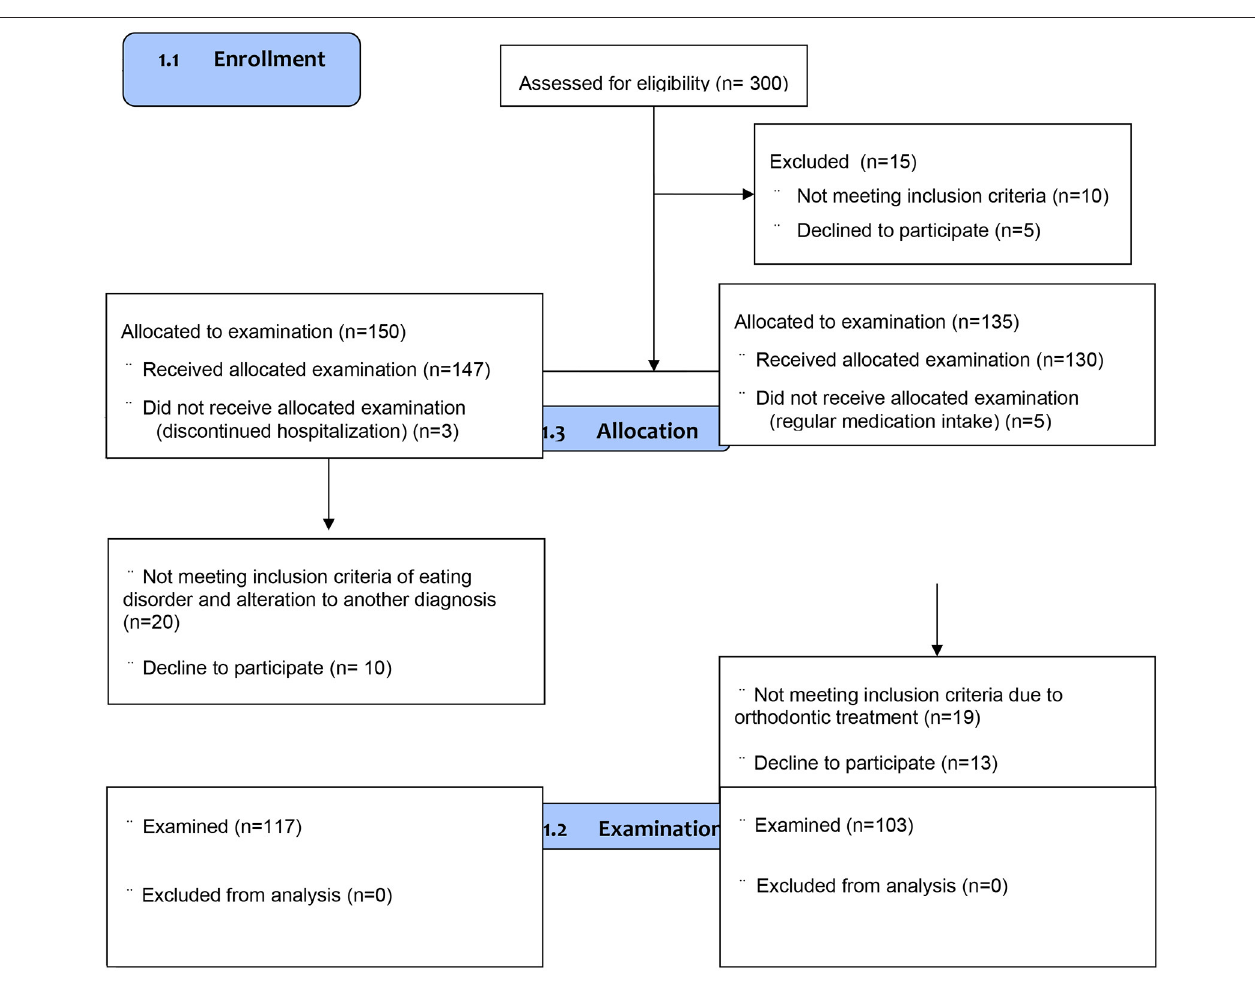
FIGURE 1 | Flow chart of the